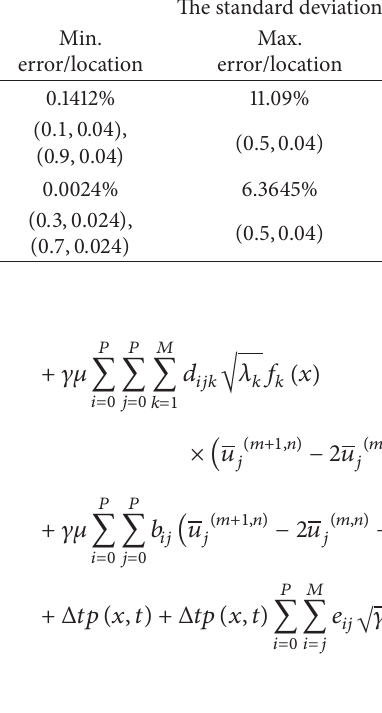
Table 1: Errors and accuracy for the stochastic diffusion equation. The mean The standard